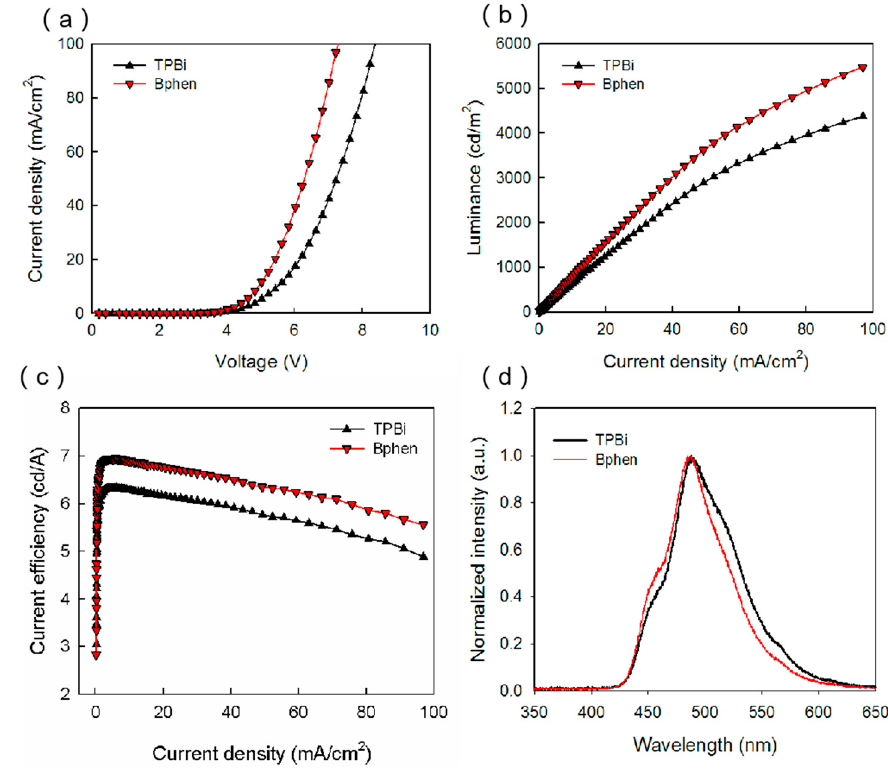
Figure 4. ( a ) Current density versus voltage curves, ( b ) luminance versus current density curves, ( c ) current efficiency versus current density curves, ( d ) normalized EL spectra of blue OLEDs with TAPC HTL and 4,7-Diphenyl-1,10-phenanthroline (Bphen), TPBi ETLs.